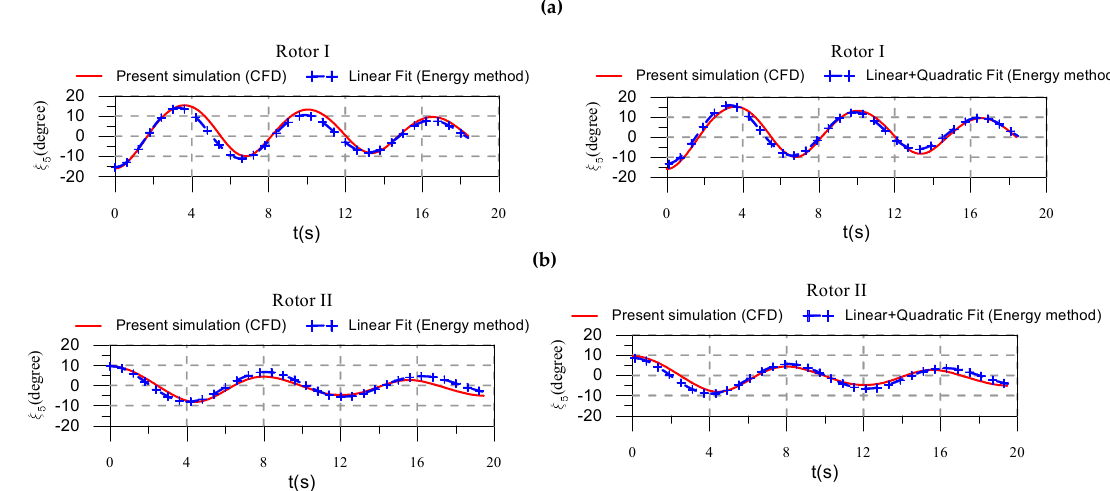
Figure 8. ( a ) Rotor I and ( b ) Rotor II; comparison of CFD and energy-based linear and linear plus quadratic free decay estimation method for different rotors. Table 4. Estimated pitch damping moment coefficients from the free decay tests using the energy method.